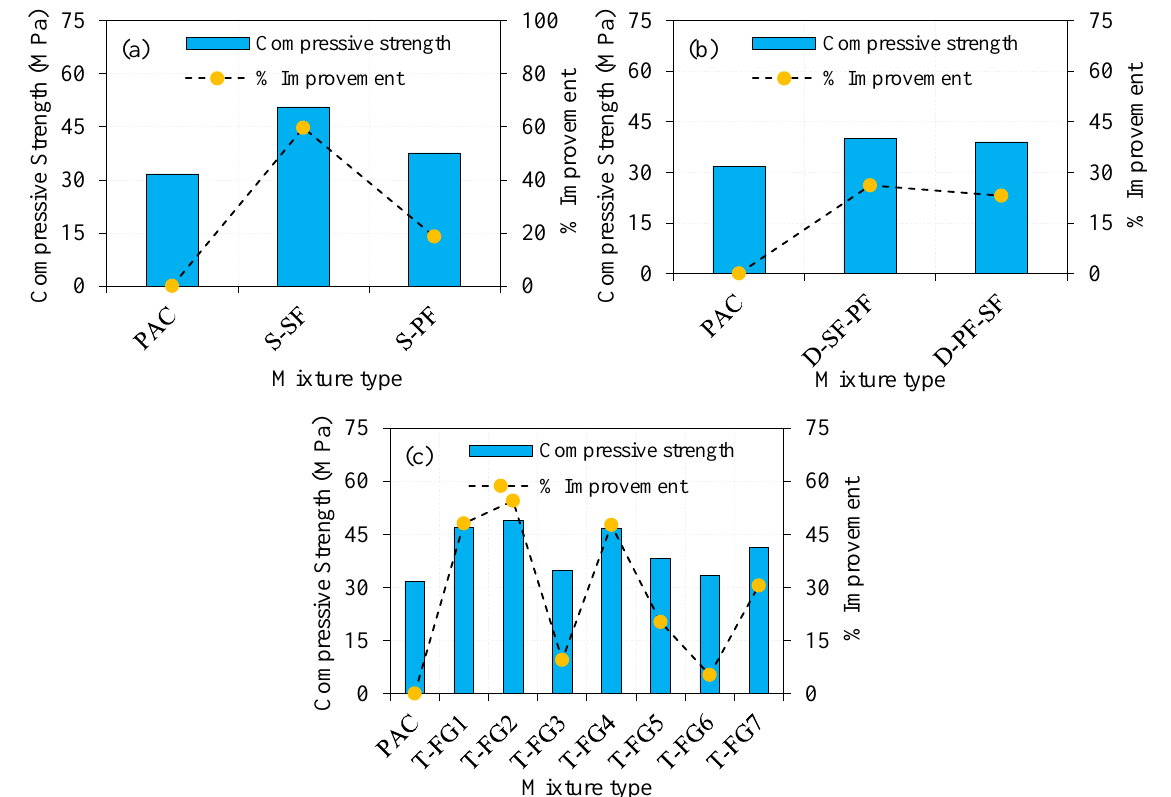
Figure 8. Observed compressive strength of FPAFC ( a ) Single layer, ( b ) Double layer and ( c ) Triple layer.